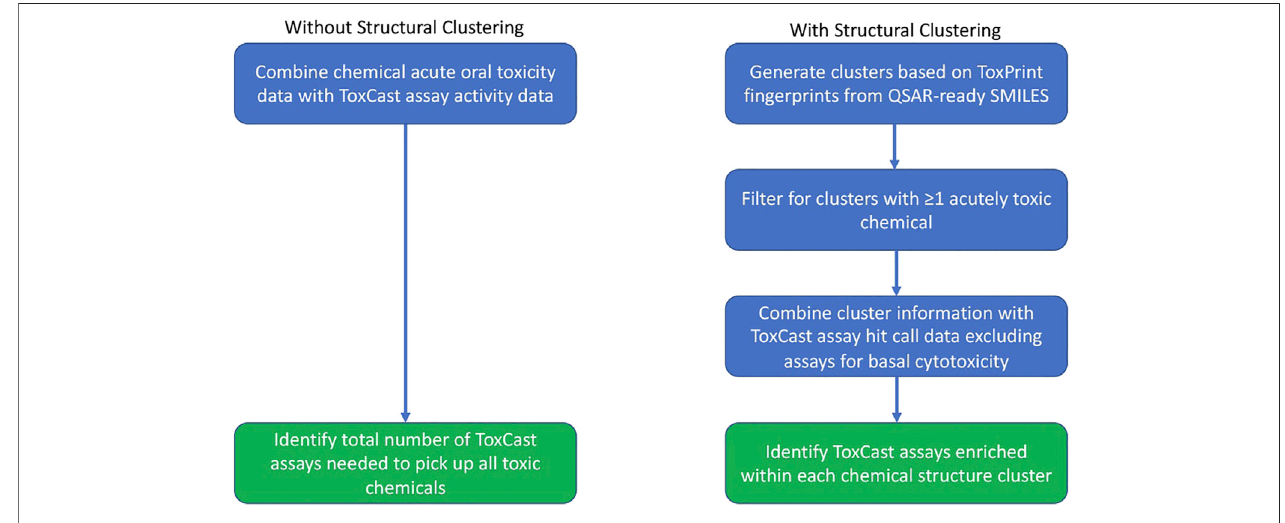
FIGURE 1 | Work fl ow undertaken for the assay analysis both with and without use of the chemical clusters generated based upon structural similarity.